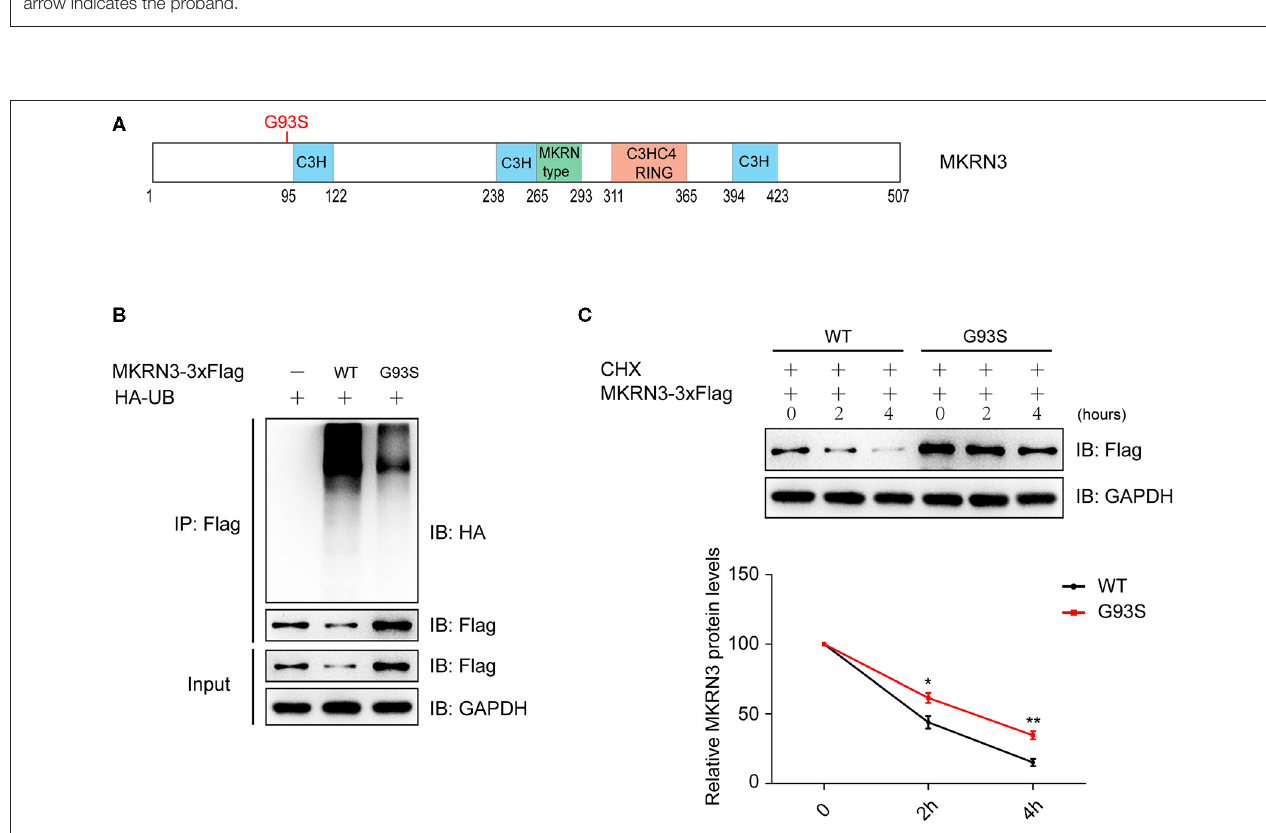
FIGURE 2 | Mutation of MKRN3 attenuated its autoubiquitination and degradation. (A) Schematic view of human MKRN3 protein mutation involved in this study. H, histidine; C, cysteine. (B) Ubiquitination of the wild-type MKRN3 protein was more significant than that of the disease-associated mutant (G93S) in HEK293T cells. Cells were transformed with plasmids encoding HA-Ub and Flag-tagged wild-type MKRN3, or MKRN3 (G93S) mutant. MKRN3 proteins were immunoprecipitated using anti-Flag beads followed by immunoblotting with anti-HA to detect ubiquitination signals. WT, wild-type. (C) The wild-type MKRN3 protein was less stable than the G93S mutant. Flag-tagged wild-type MKRN3 or G93S mutant were expressed in HEK293T cells. Cells were treated with CHX (100 ug/ml) at different time durations (0, 2, or 4h) before harvest for immunoblotting analysis. Data are presented as mean ± SD, one-way ANOVA was used with the Bonferroni post-hoc test over three independent experiments. * P < 0.05, significant difference; ** P < 0.01, very significant difference, over three independent